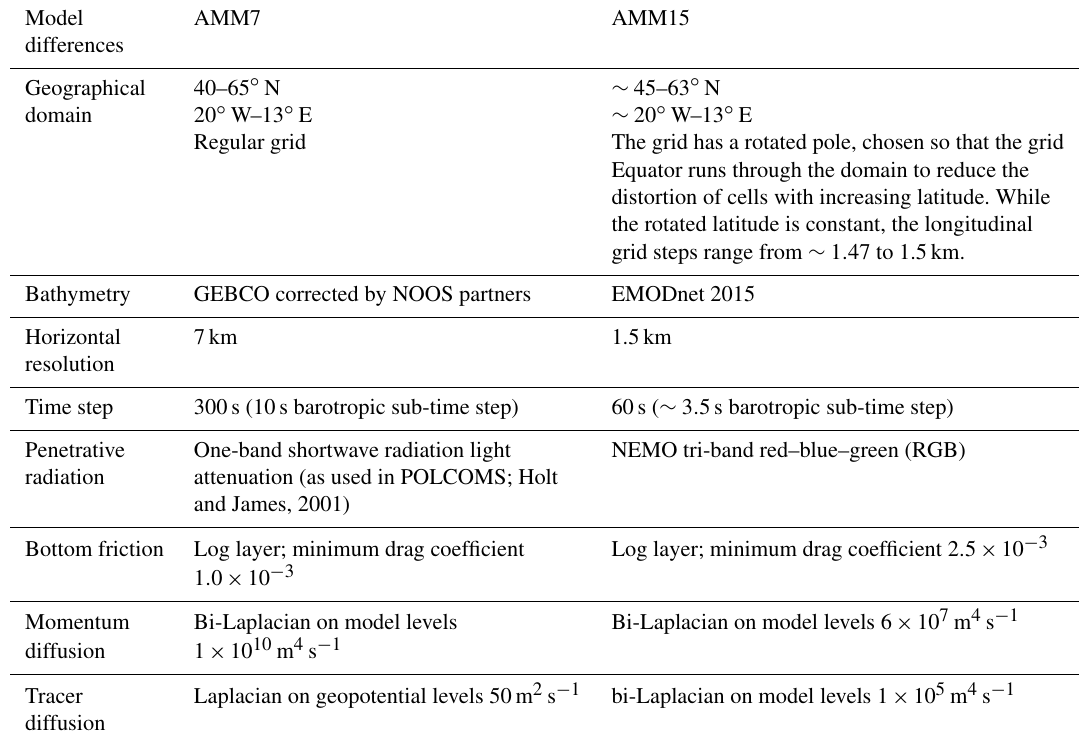
Table 1. Summary of the AMM15–AMM7 model differences. Model AMM7